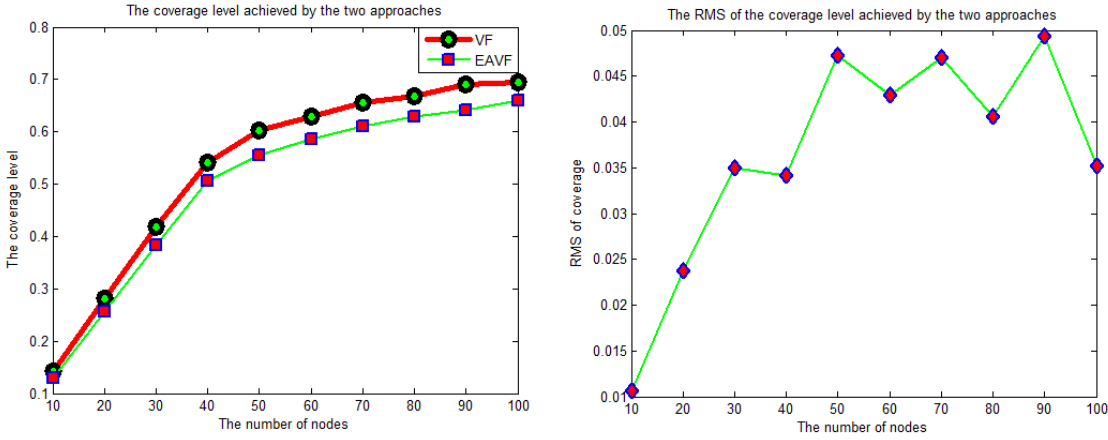
Figure 12. ( A ) The coverage level achieved using the energy-aware version and the original version. ( B ) The root mean square of the difference between the coverage level of the two approaches.